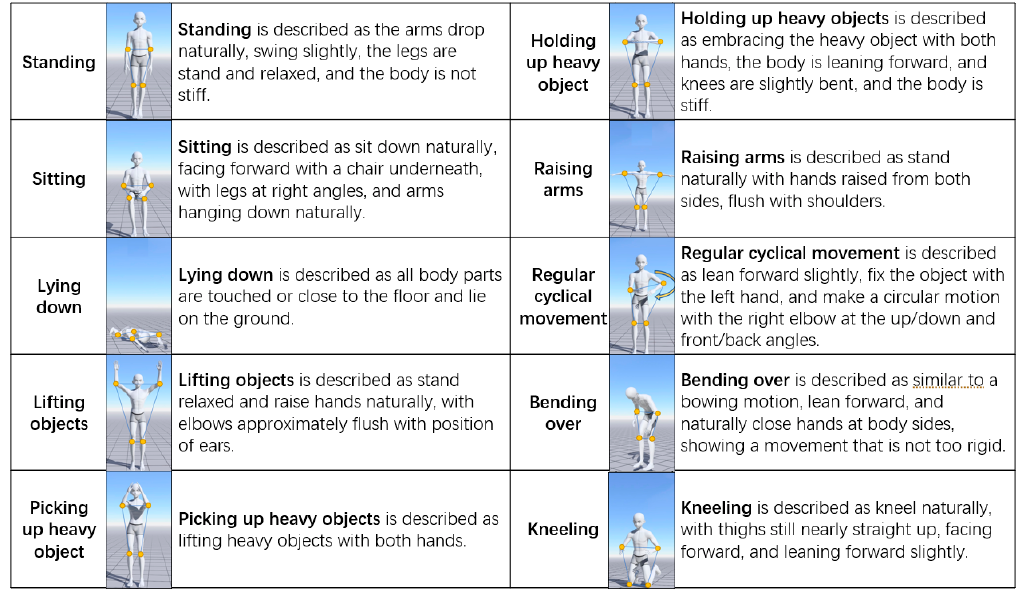
Figure 6. A detailed description of detected motions.